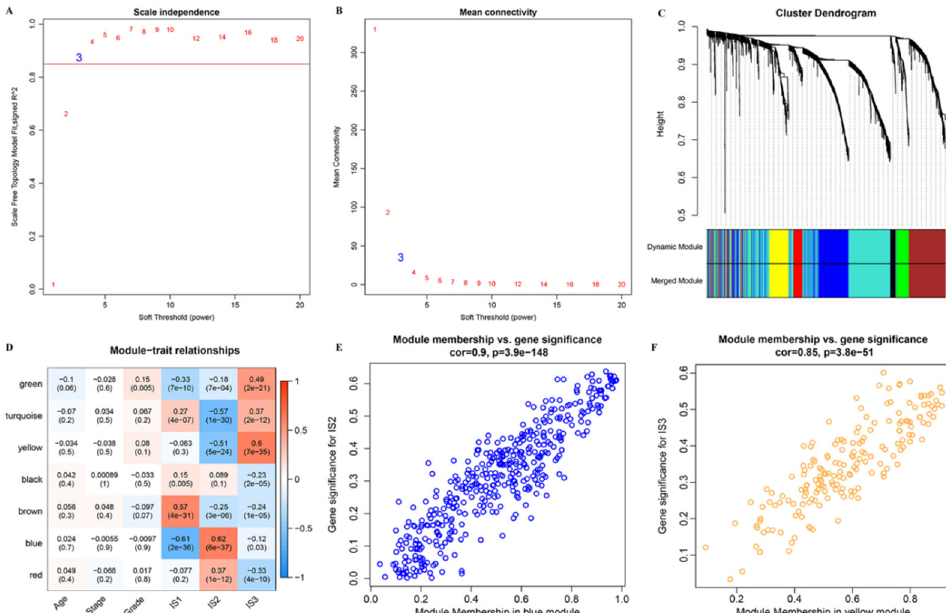
Figure 8. Identification of the immune gene co-expression module of OC. ( A ). Scale-free fit index for various soft-thresholding powers ( β ). ( B ). Mean connectivity for various soft-thresholding powers. ( C ). Dendrogram of all differentially expressed genes clustered; ( D ). Heatmap of the correlations between the 7 modules and three immune subtypes. ( E ): Scatter diagram of genes with significant correlations with the IS2 subtype in the blue module. ( F ): Scatter diagram of genes with significant correlations with the IS3 subtype in the yellow